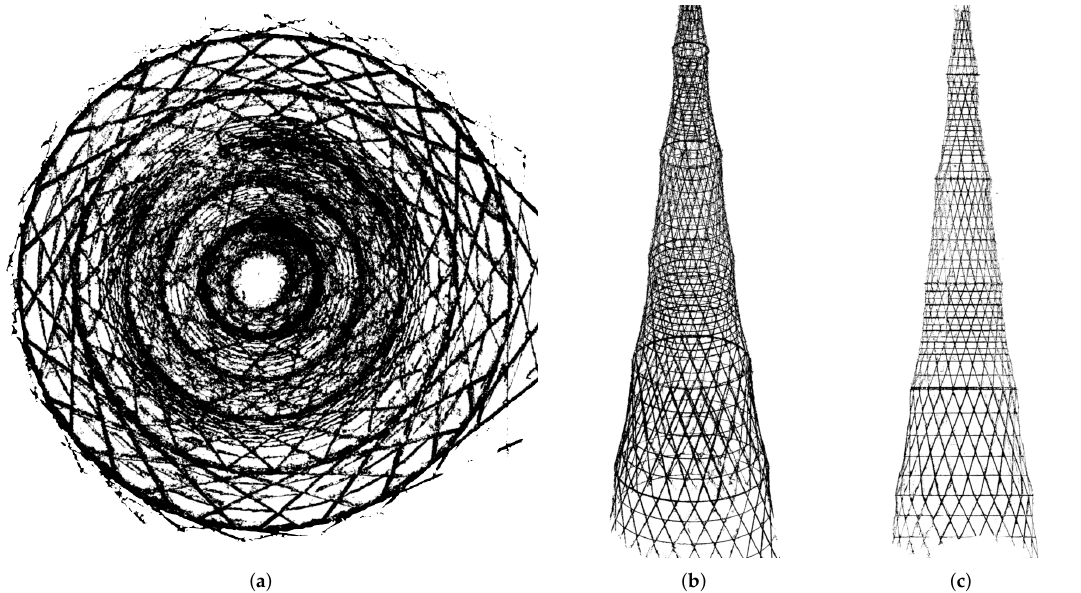
Figure 13. Dense 3D point cloud of Shukhov tower (4.2 mil points): bottom view ( a ), isometry view ( b ) and front view ( c ), with rear part eliminated for better presentation.